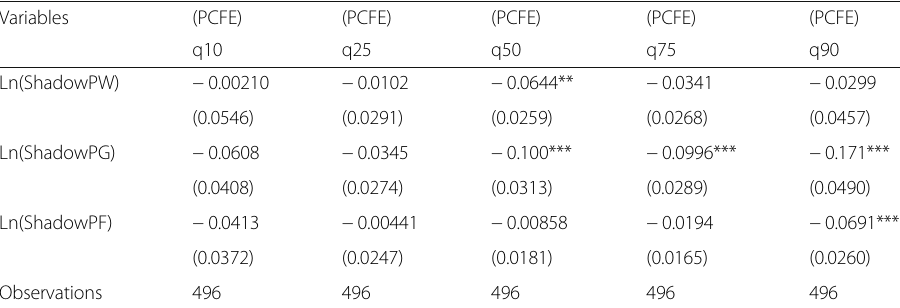
Table 7 Effect of water, grazing, and feed scarcity on log PCFE using quantile regression Variables (PCFE)